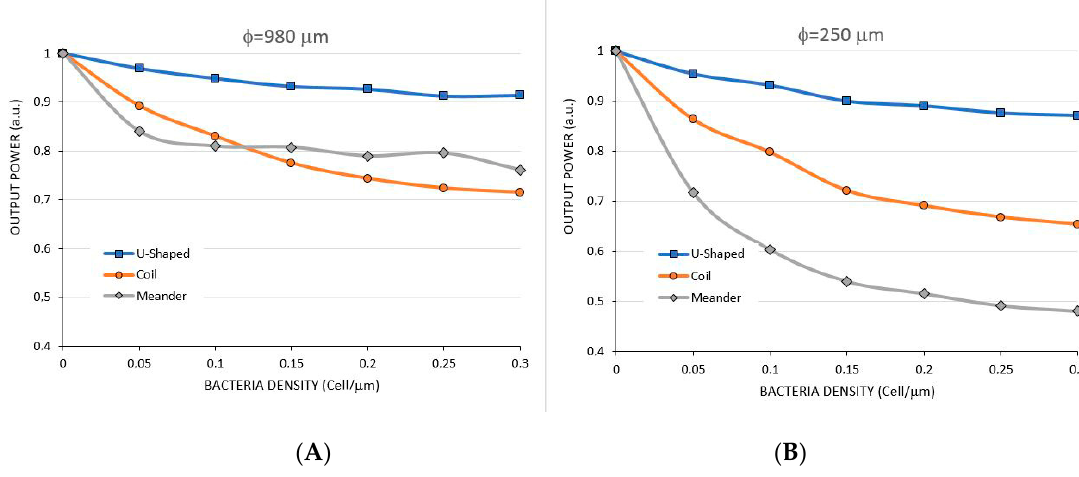
Figure 13. Comparing the sensitivity between U-Shaped, Coil and Meander-shaped with φ = 980 µm, R = 5.0 mm ( A ) and φ = 250 µm, R = 1.5 mm sensor ( B ) for bacteria sensing.